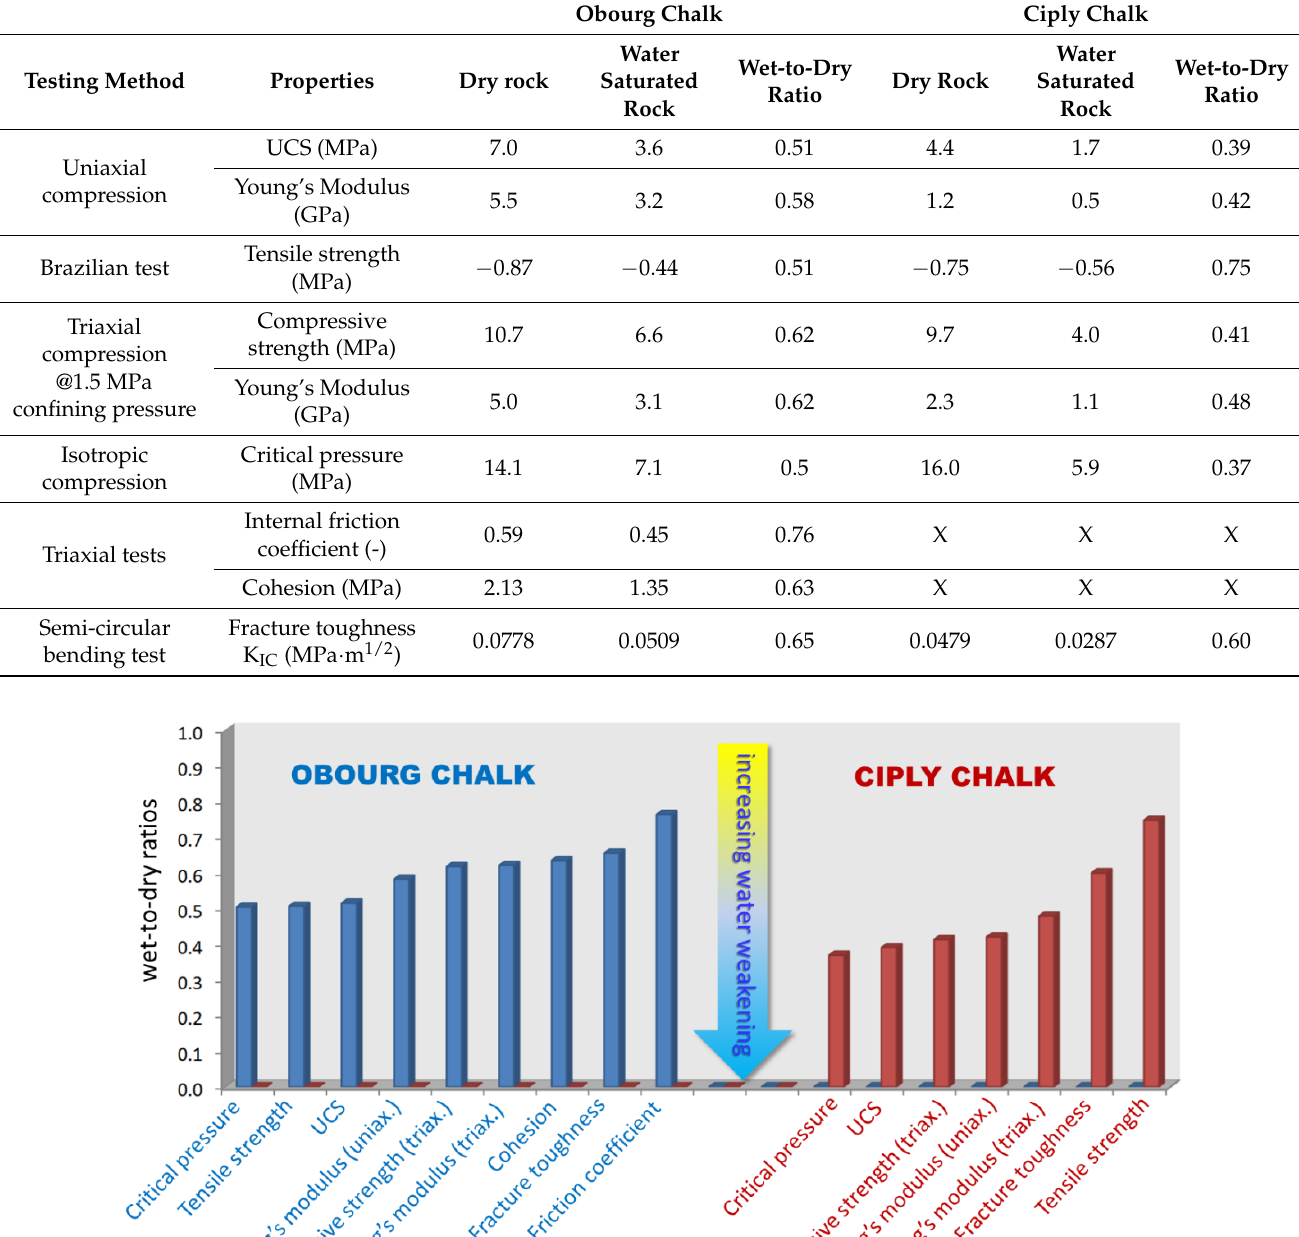
Table 7. Compilation of experimental results for the mechanical tests conducted on the dry and water-saturated chalks. The wet-to-dry ratios WDR( Λ ) are given for the corresponding parameters Λ .